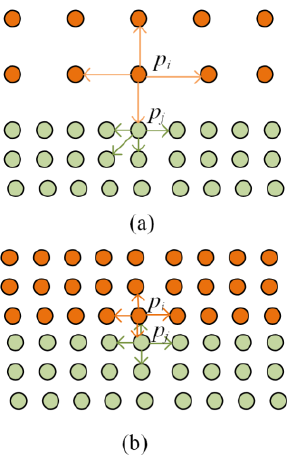
Figure 3. Recovery of adjacency between supervoxels and points. The red and green points refer to two different supervoxels. (a) shows two points are not adjacent because p i is not the K min nearest neighbours of p j and (b) shows two adjacent points that are mutually in each other's K min nearest